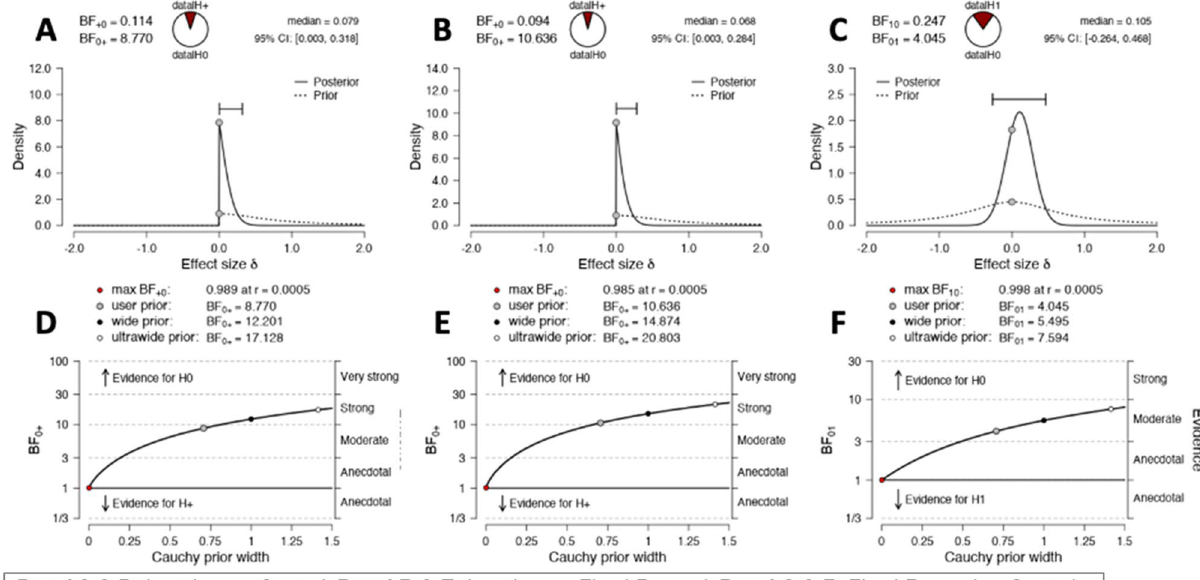
Figure 2. Prior and Posterior Plots, and Robustness Checks for Bayesian T-Tests.